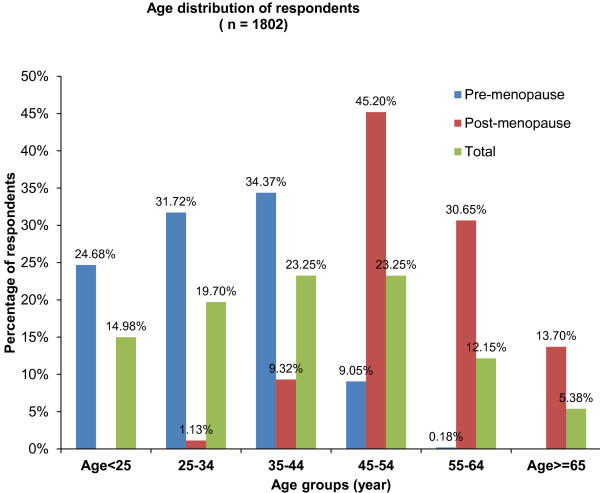
Age distribution of respondents by menopausal status.